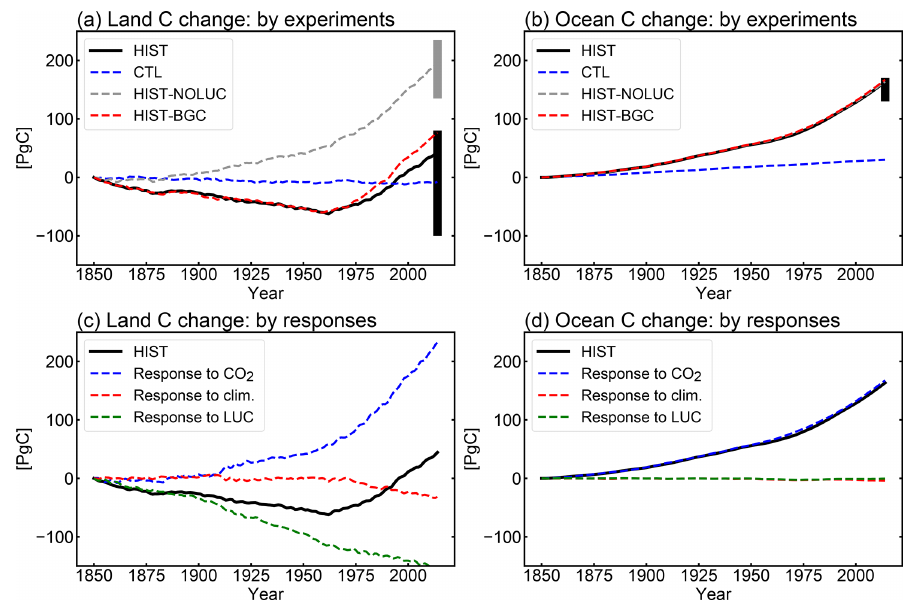
Figure 8. Land and ocean carbon change (i.e., cumulative net carbon uptake by land and ocean) in historical simulations. (a, b) Simulation results of the historical (HIST, black lines), historical without land use change (HIST-NOLUC, dashed gray), historical without climate change (HIST-BGC, dashed red), and control (CTL, dashed blue) runs. For land calculation, the carbon amount change in product pools for land use is considered. Vertical bars represent uncertainty ranges estimated from Le Quéré et al. (2018). Black bars correspond to the HIST (1850–2014) run result, and the gray bar represents the uncertainty range for the natural carbon sink of land, which corresponds to the HIST-NOLUC run in this study. (c, d) The HIST run result shown again (black lines) together with the decomposed response of land–ocean carbon driven only by CO 2 increase (dashed blue), climate change (dashed red), and LUC (dashed green). Note that the ocean in MIROC- ES2L considers carbon removal via the sedimentation process onto ocean floor; thus, the model exhibits continuous carbon uptake, even in the CTL experiment. Table 3. Key variables of global land biogeochemistry: preindustrial condition (average of 10 years) and the 2000s in the historical run